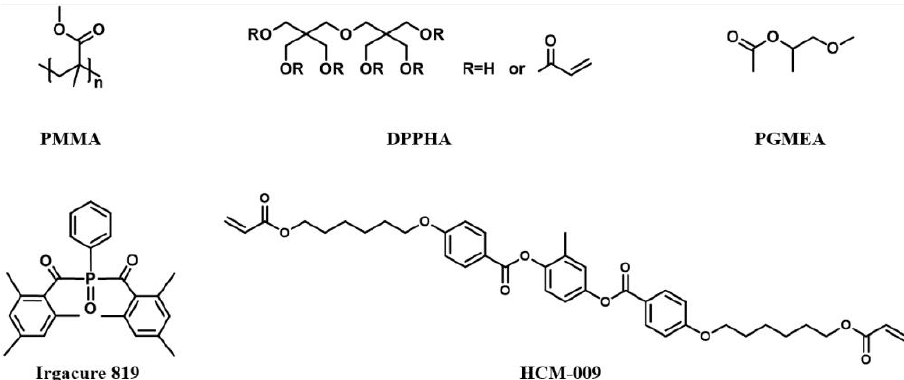
Figure 1. Chemical structures of the materials used in the study.